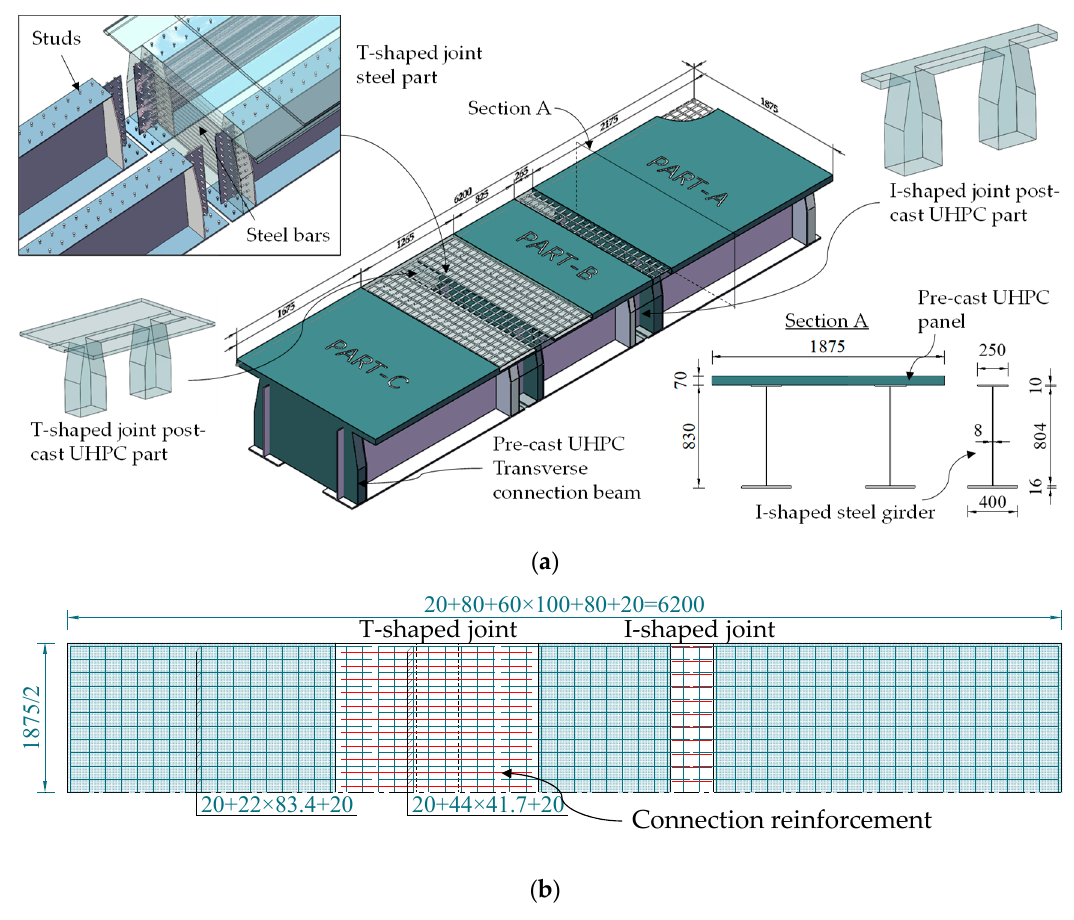
Figure 3. Illustration of the comparative model test (units: mm): ( a ) specimen display; ( b ) reinforcement layout.